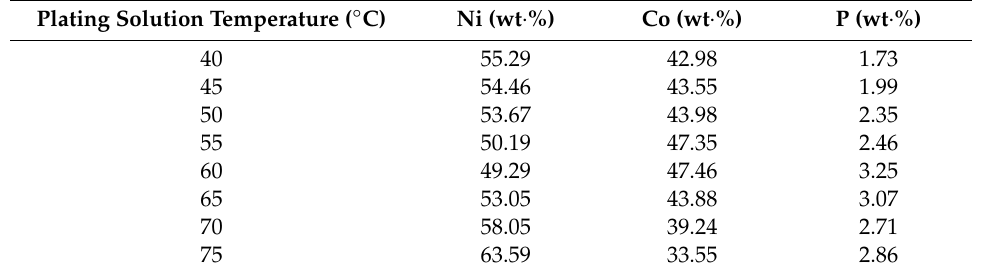
Table 5. Effect of the temperature of the plating solution on the element content of Ni–Co–P alloy coatings. Plating Solution Temperature ( ◦